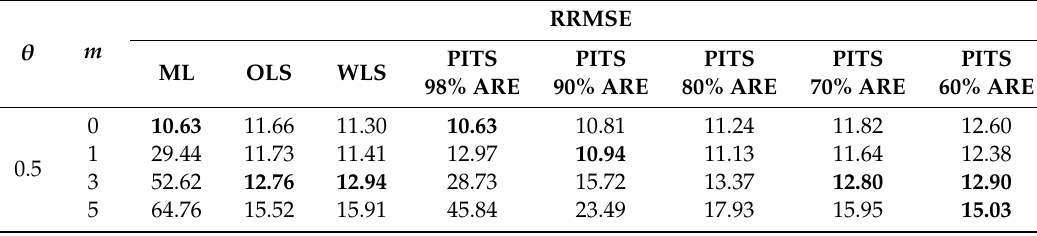
Table 4. RRMSE results for estimations of parameter θ with n = 50 and m = 0, 1, 3,